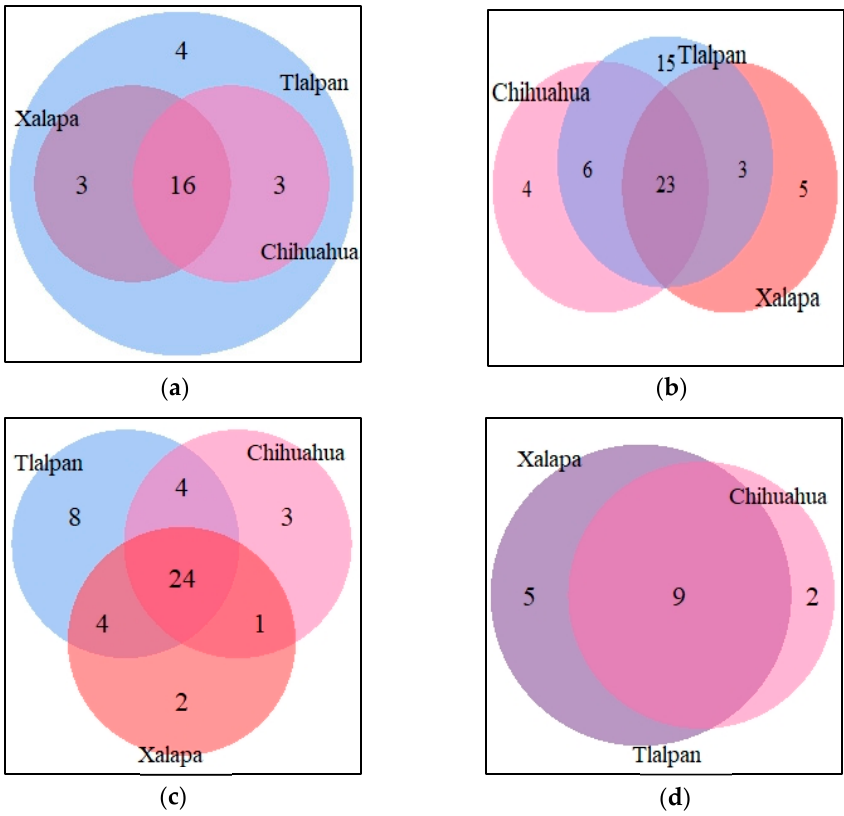
Figure 2. Venn diagram for the regions: Tlalpan, Chihuahua, and Xalapa. ( a ) HLA-A alleles shared in the three regions; ( b ) HLA-B alleles shared in the three regions, ( c ) HLA-DRB1 alleles shared in the three regions, ( d ) HLA-DQB1 alleles shared in the three regions. Table 1. Hardy-Weinberg equilibrium (HWE) parameters for the sample sets from three Mexican populations.